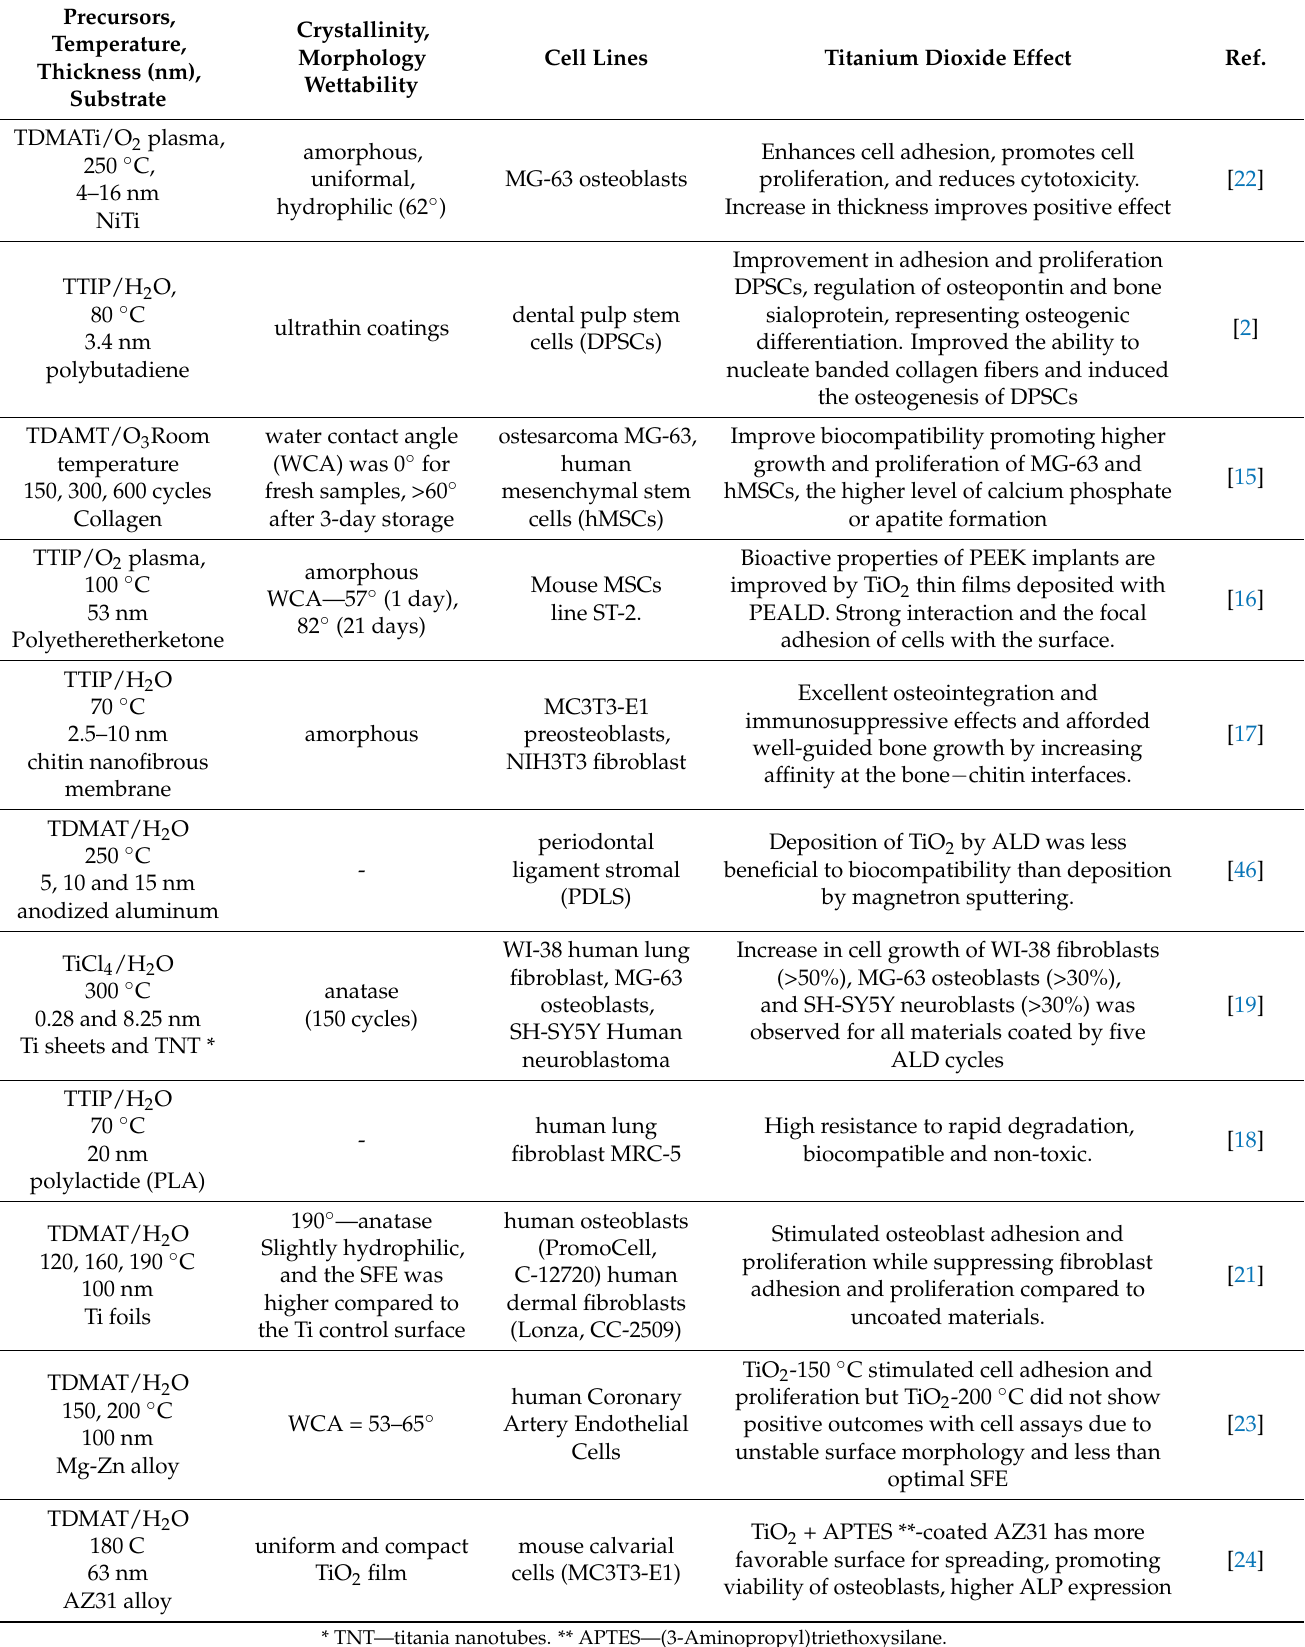
Table 3. Results of in vitro study of TiO 2 ALD coatings using different cell